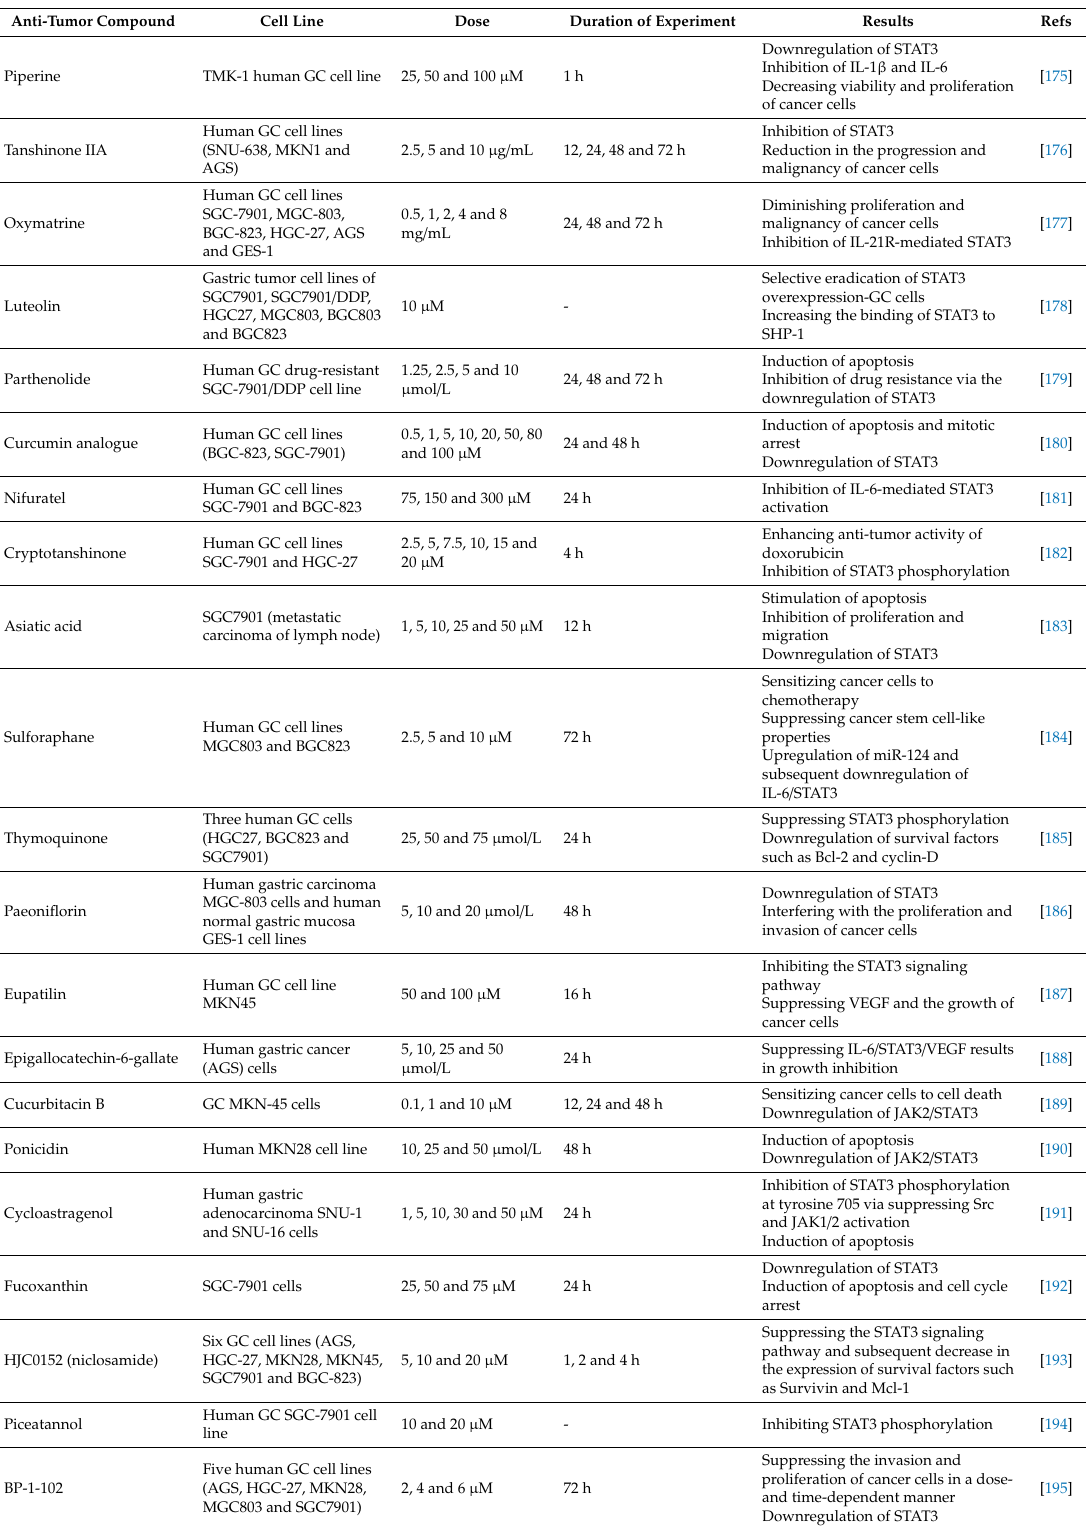
Table 4. Natural products as anti-tumor compounds in GC therapy via targeting